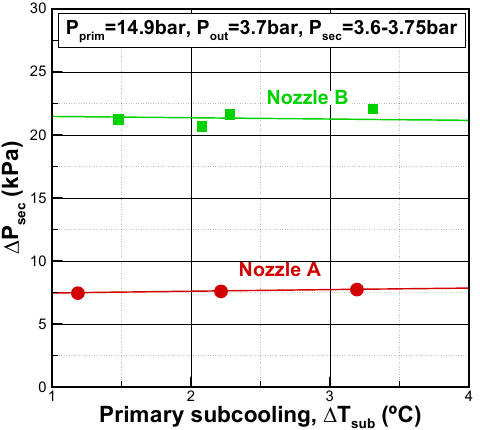
Figure 10. Expansion of the secondary flow.